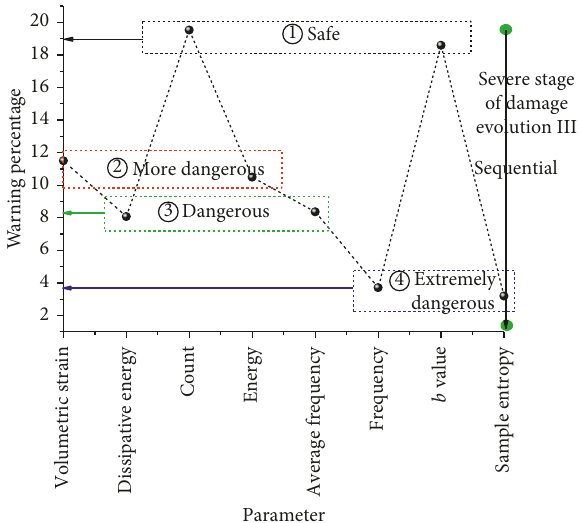
Figure 20: Parameter timing characteristics by